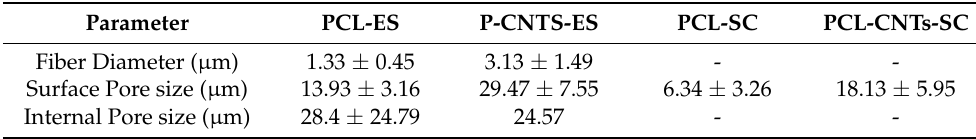
Table 2. Fiber diameter and surface pore size for electrospun and solvent cast